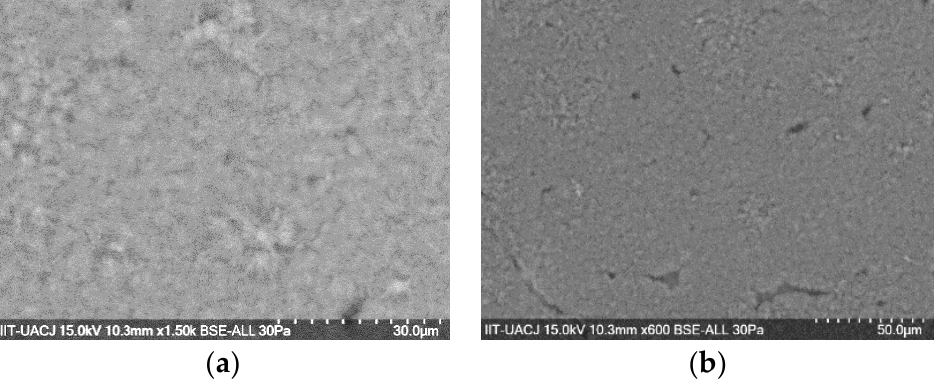
Figure 14. SEM images of P1 magnified to ( a ) 15,000 × and ( b ) 600 × , respectively. 3.3.3. Thermogravimetric Analysis and Derivate Thermogravimetric Analysis